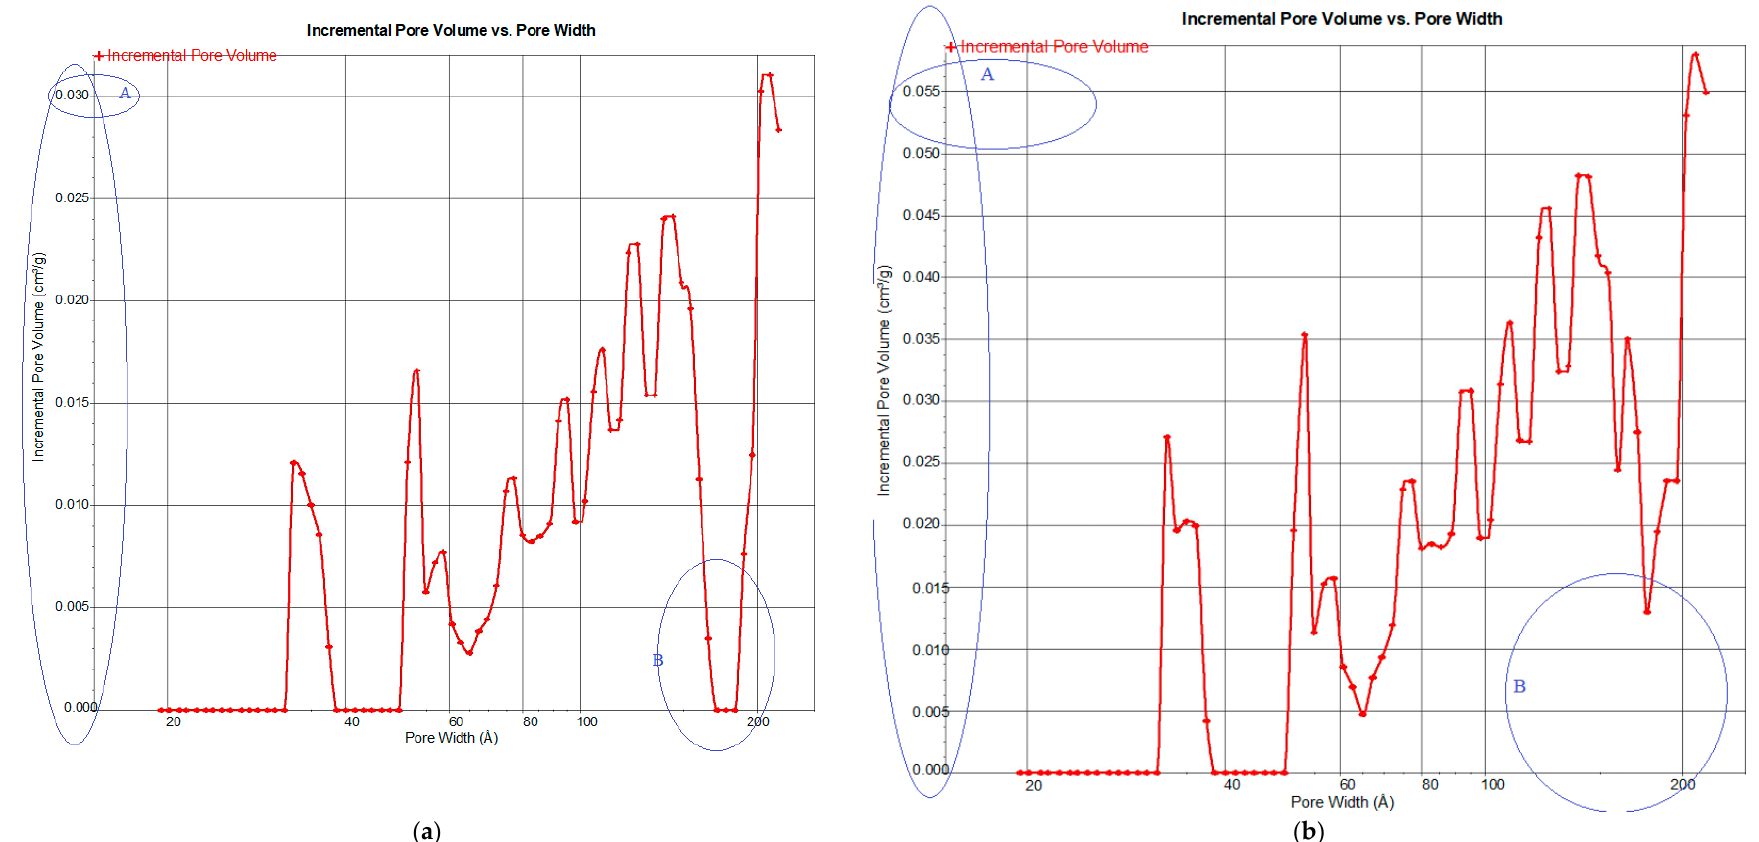
Figure 2. Incremental pore volume versus pore width of the ( a ) non-pretreated and, ( b ) microwave pretreated CSAC.